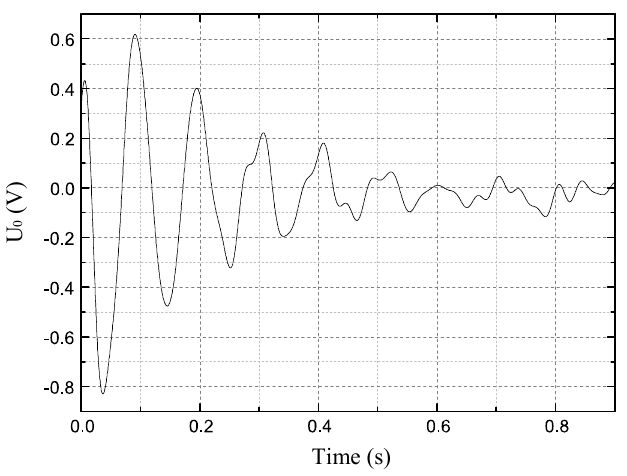
Figure 20. Zero-sequence voltage filter waveform.